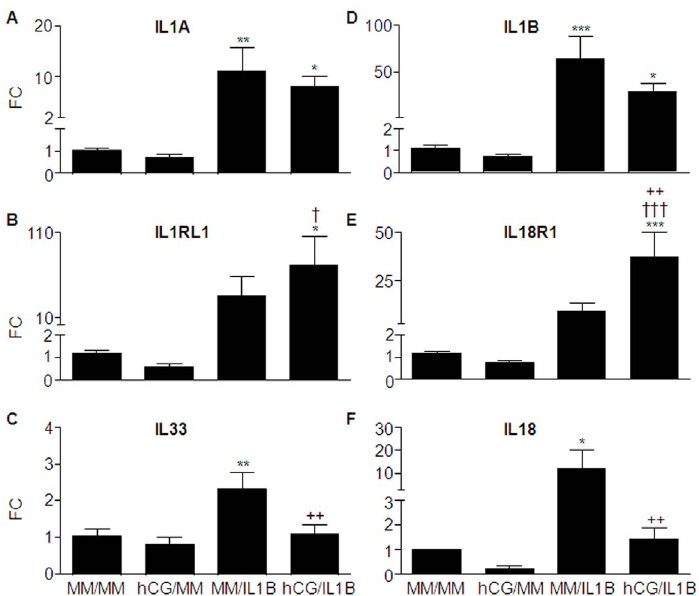
Figure 5. hCG modulates IL1B effects on the expression of IL1 family members in ESCs. Confluent ESC cultures were incubated with minimal medium (MM) or hCG (100 ng/mL) for 24 h before being exposed or not to IL1B (0.1 ng/mL) for additional 24 h. Total RNA was extracted and reverse transcribed, and mRNA levels were then quantified by qRT-PCR. IL1A (A), IL1B (D), IL1RL1 (B), IL18R1 (E), IL33 (C) and IL18 (F) mRNA ratio was then determined following normalization to GAPDH mRNA (internal control). Data were from ESC cultures issued from 7 different subjects and expressed as fold change (FC) over control (ratio of IL1A, IL1B, IL1RL1, IL18R1, IL33 or IL18 mRNA levels found in cells incubated with IL1B, hCG or hCG/ILB to those found in cells incubated with MM for an equivalent period of time). *P , 0.05, **P , 0.01, *** P , 0.001 relative to MM; { P , 0.05, {{{ P , 0.001 relative to cells stimulated with an equivalent concentration of hCG; ++ P , 0.01 relative to cells stimulated with an equivalent concentration of IL1B. Data were obtained with ESC cultures issued from 7 different subjects (the 3 cultures used for microarray analysis and 4 additional cultures).